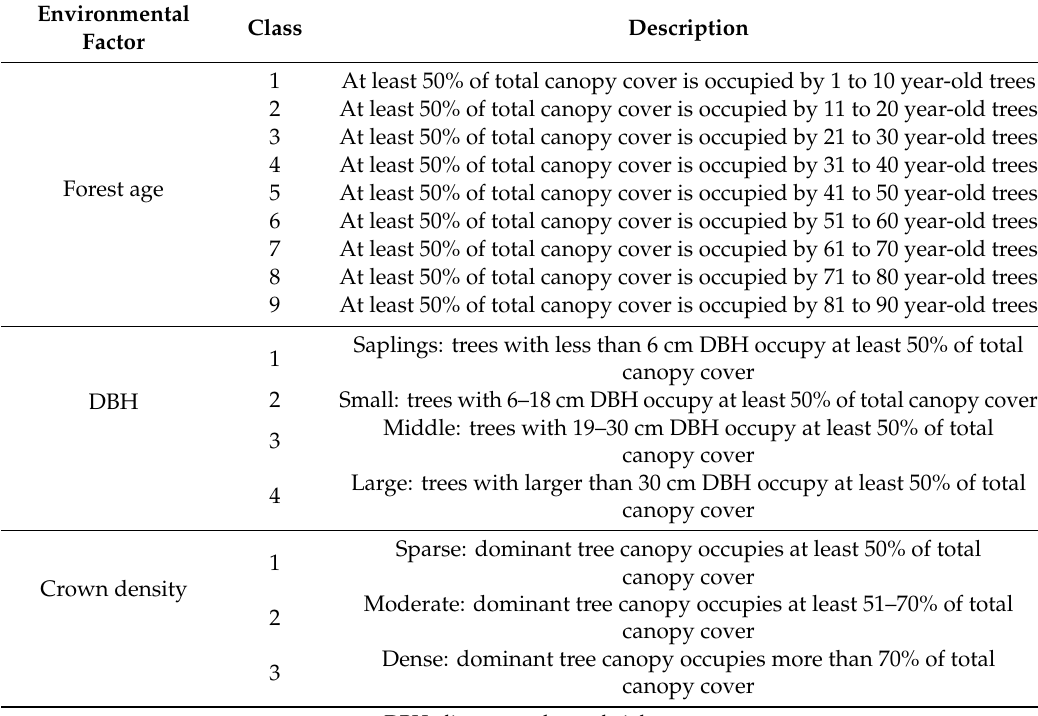
Table 1. Classification and description of environmental